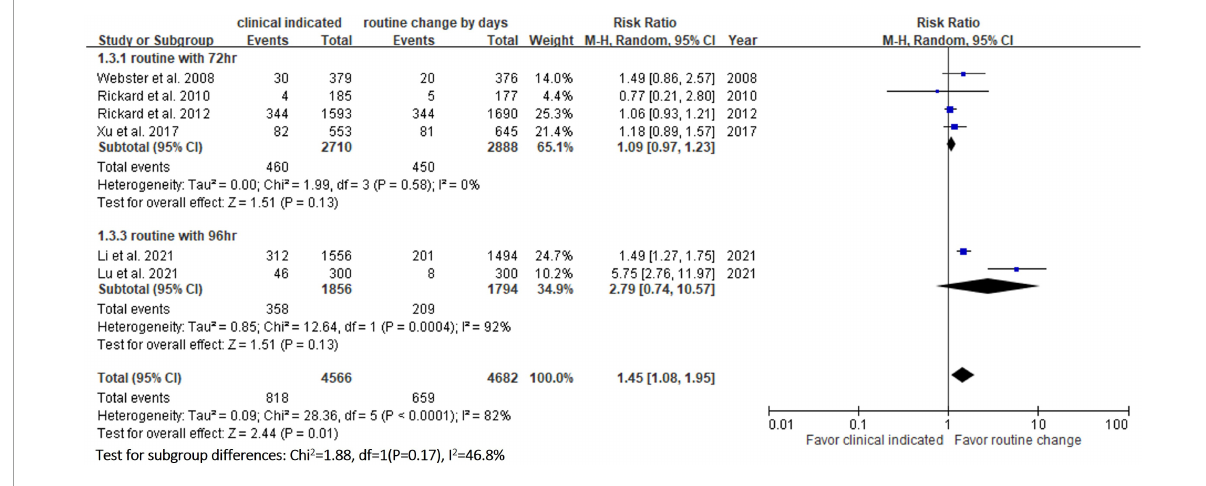
FIGURE7 Forest plot of the risk of catheter-related bloodstream infection.